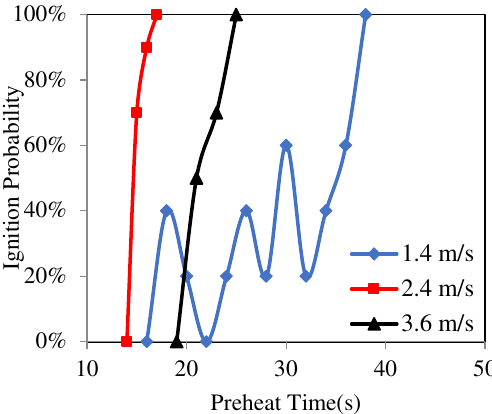
Figure 2. Ignition probability with different air flow velocities under the fuel flow rate of 7.3 mL/min.